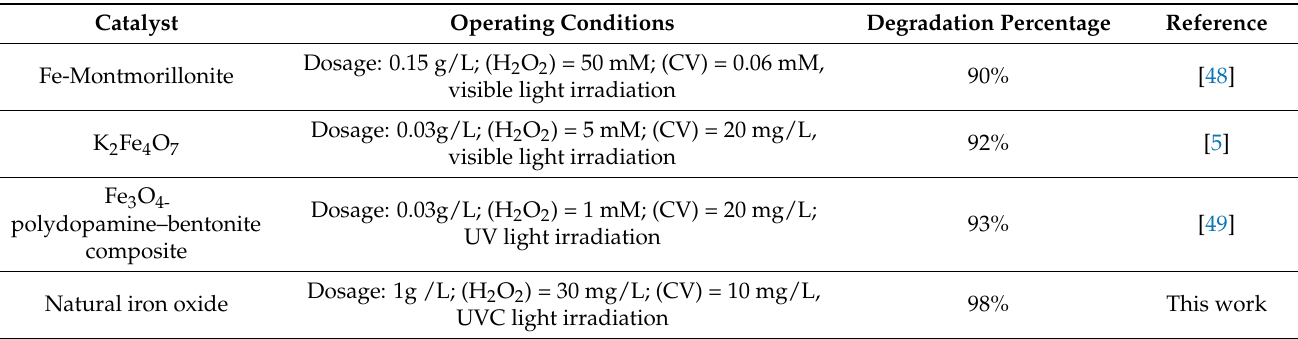
Table 2. Comparison of natural iron oxide with different photocatalysts for CV dye degradation by photo-Fenton process.